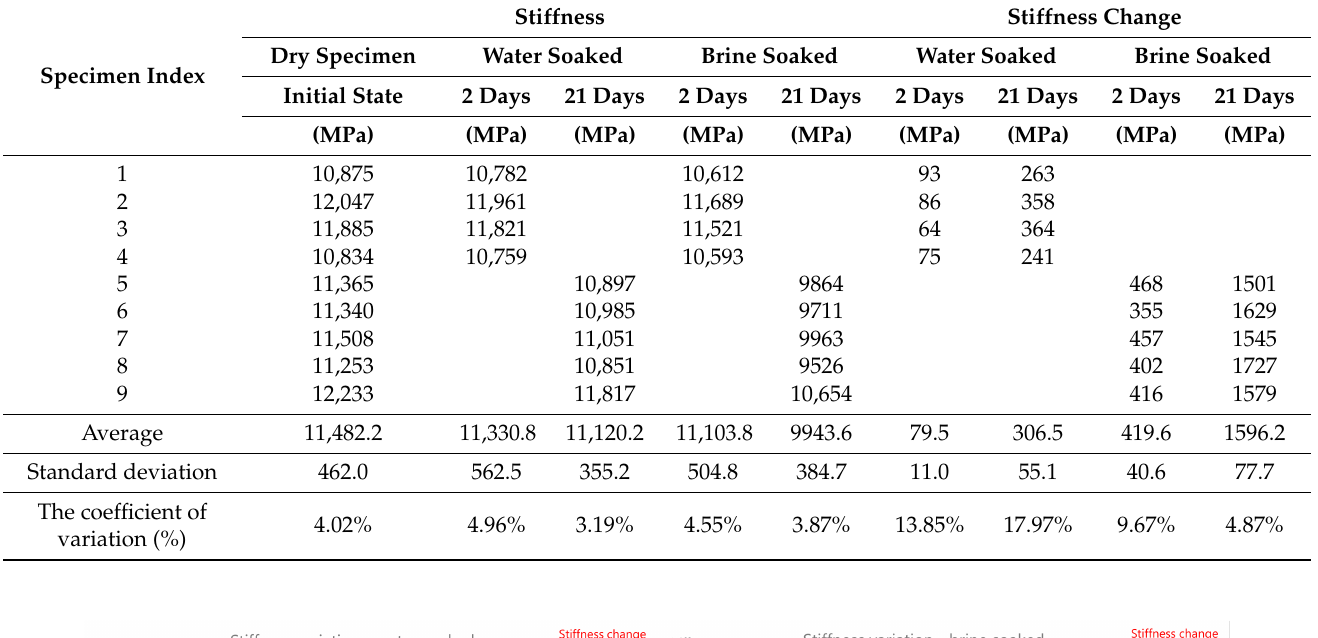
9.2 g, and that for brine is 15.7 g. The mass of the deposited salt after 2 days is 6.5 g, and